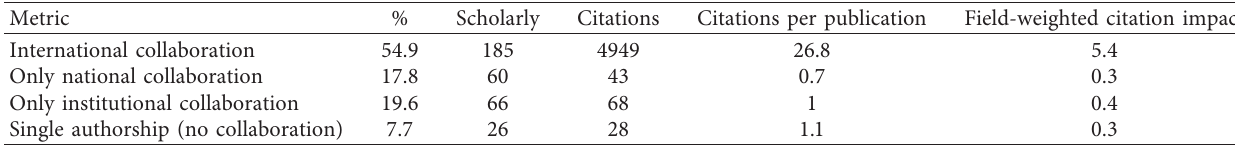
Table 1: Scholarly output in public and private Faculties of Dentistry by the amount of international, national, and institutional col- laboration (2014–2019).